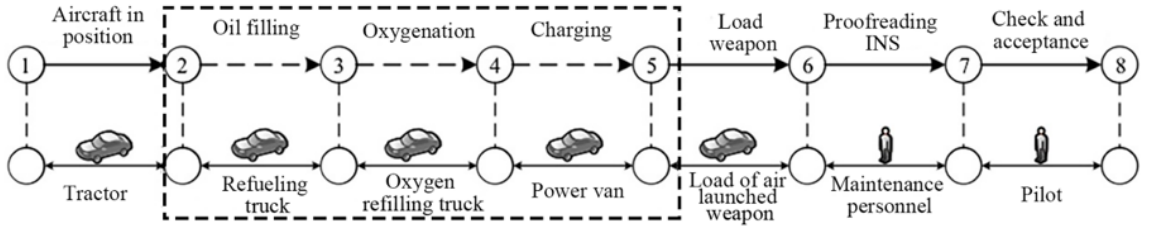
Figure 1. Apron support vehicle operation